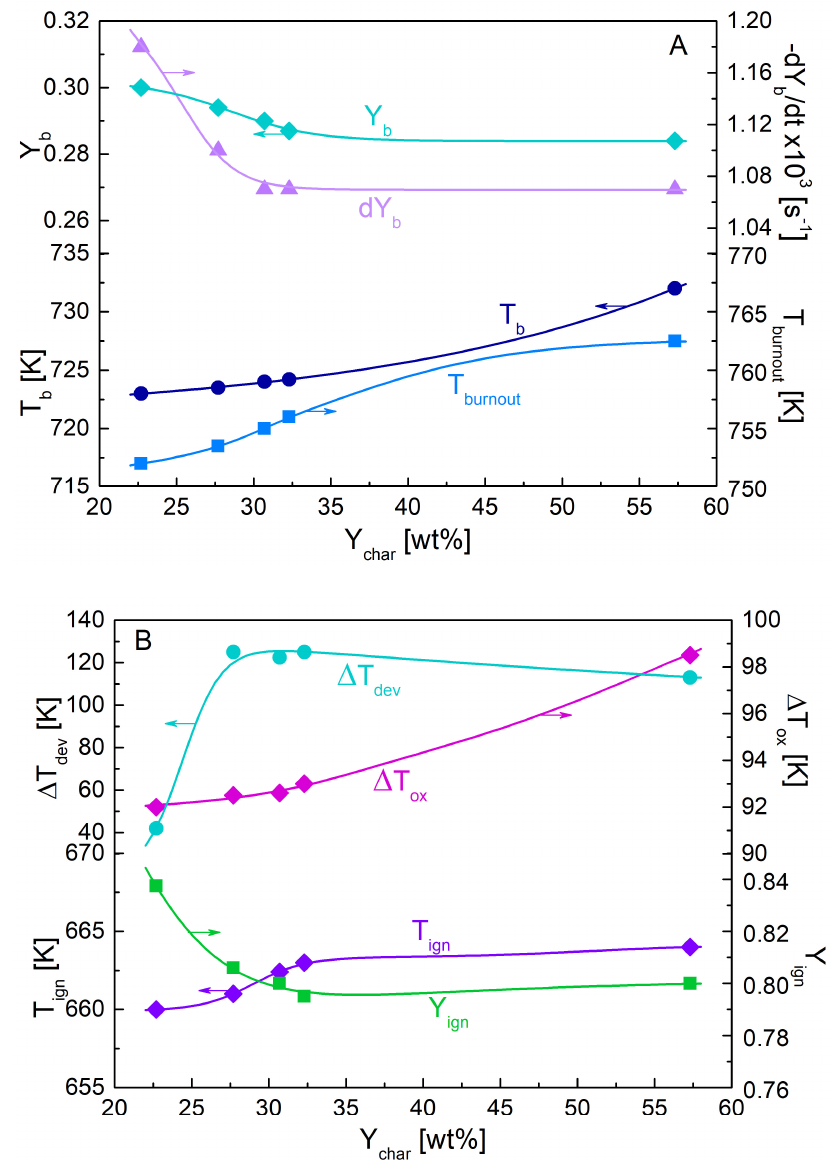
Figure 3. Thermogravimetric parameters dY b , T b , Y b , T burnout ( A ), and T ign , Y ign , Δ T ox and Δ T dev ( B ), versus the torrefaction degree expressed in terms of pyrolysis char yield, Y char